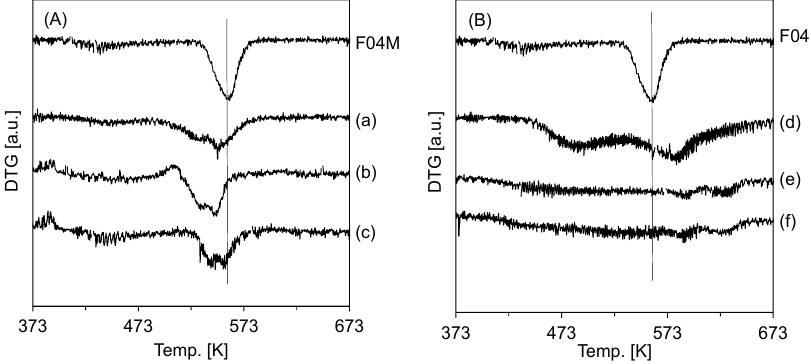
Figure 2. DTG curve registered upon H 2 ‐ TPR of F04M catalyst coated with silica (a,d), zirconia (b,e), and titinia (c,f) using ammonia ( A ) and L(+) ‐ arginine ( B ).